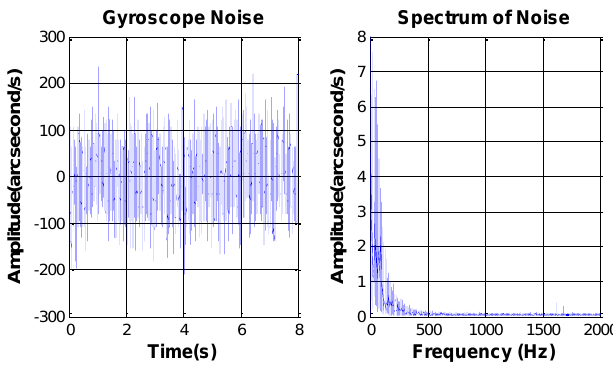
Figure 8. Micro-electro-mechanical system (MEMS) gyroscope noise characteristics.